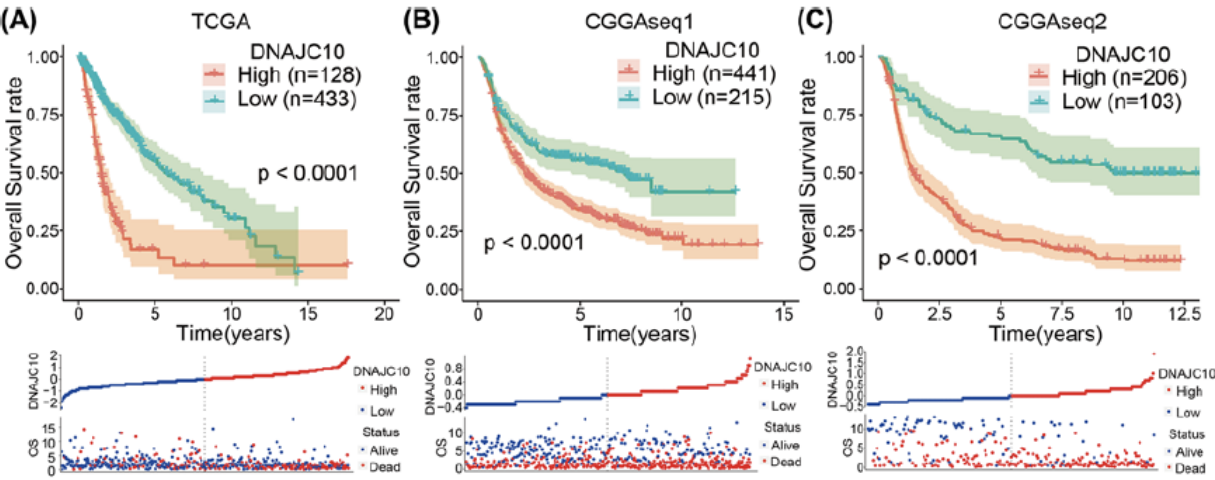
Figure 5. High DNAJC10 expression indicates poor prognosis of glioma patients ( A – C ). Kaplan–Meier survival curves indicated that glioma patients with higher DNAJC10 expression levels showed shorter survival time and rate in three independent glioma cohorts (TCGA, CGGAseq1, and CGGAseq2) [71].